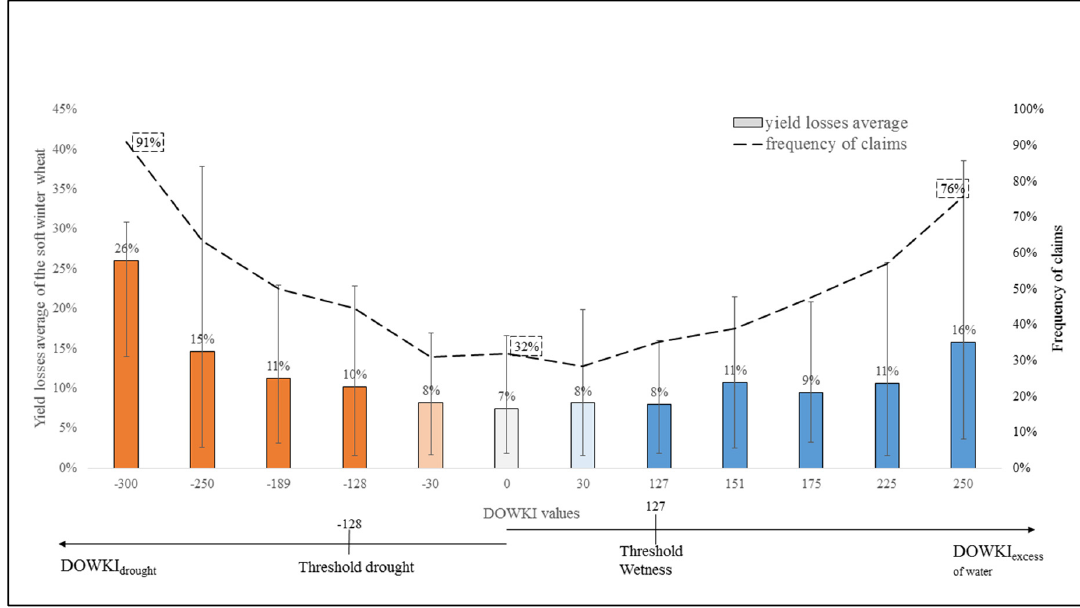
Figure 5. Damage functions for soft winter wheat yield loss simulations: frequency of claims, percentile 10 and 90, average of yield losses according to DOWKI values. 10 and 90, average of yield losses according to DOWKI